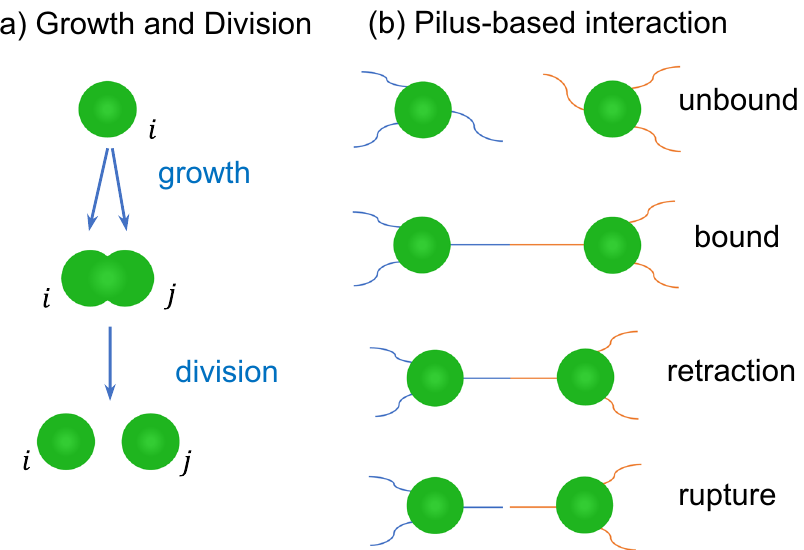
Fig. 1 Schematic representation of the two active processes occurring in the simulations. a A bacterium grows into a diplococcus and then divides into two individual bacteria. b Two cells bind to each other via pili. Subsequently, pili are retracted by the bacteria leading to a force build-up. The bond connecting the pili ruptures stochastically in a force-dependent